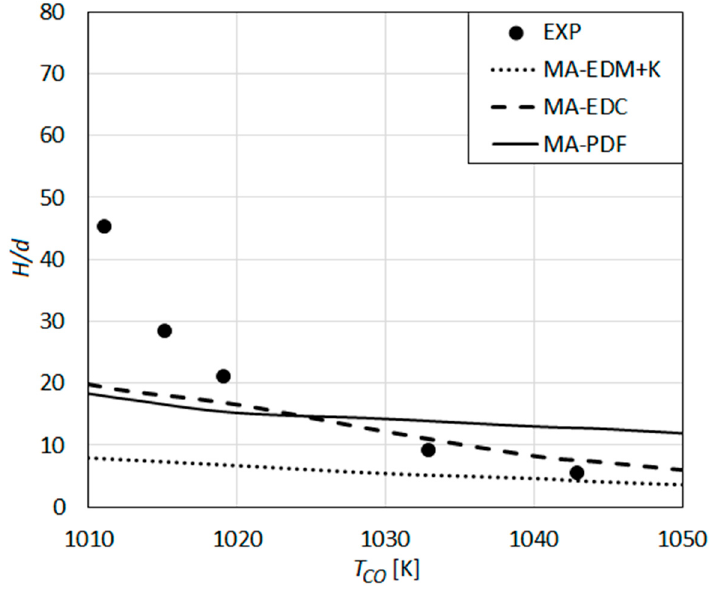
Figure 8. Lift-o ff height as a function of co-flow temperature: Predictions using the global reaction mechanism of Marinov et al. [58] compared with the measurements of Wu et al.